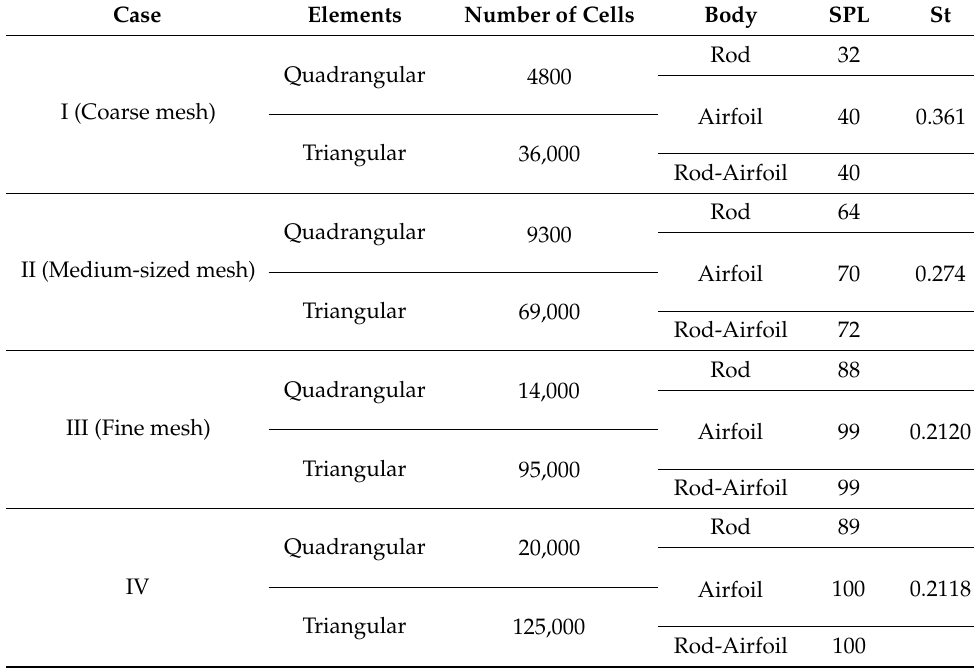
Table 3. Examining independency of the problem results from the